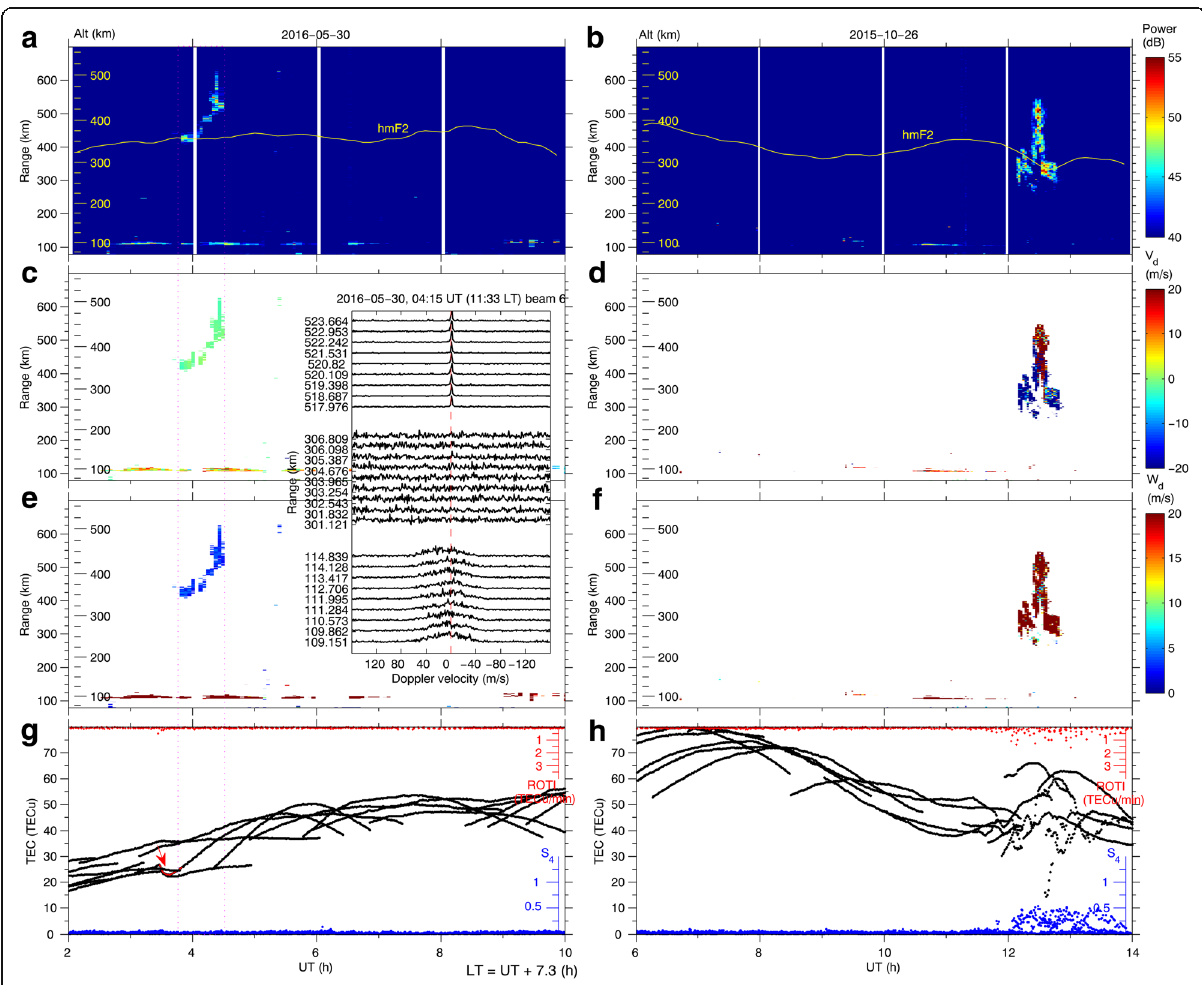
Fig. 1 a , b Range-time-intensity, c , d Doppler velocity, and e , f Doppler spectral width maps of backscatter echoes measured by the Fuke (19.3° N, 109.1° E) radar beam 6 on May 30, 2016, and October 26, 2015, respectively. g , h Temporal variations of TEC, rate of TEC change index, ROTI, and scintillation S 4 measured by the Sanya (18.3° N, 109.6° E) GNSS receiver on the 2 days. The hmF2 variations over Sanya on the 2 days are shown as yellow curves in panels a and b . The inset in the left middle panels shows an example of Doppler spectra. The dash-dotted red vertical lines in the left plots mark the period when the F-region irregularity growth was observed. The red arrow in panel g marks the TEC reduction just prior to the appearance of the F-region